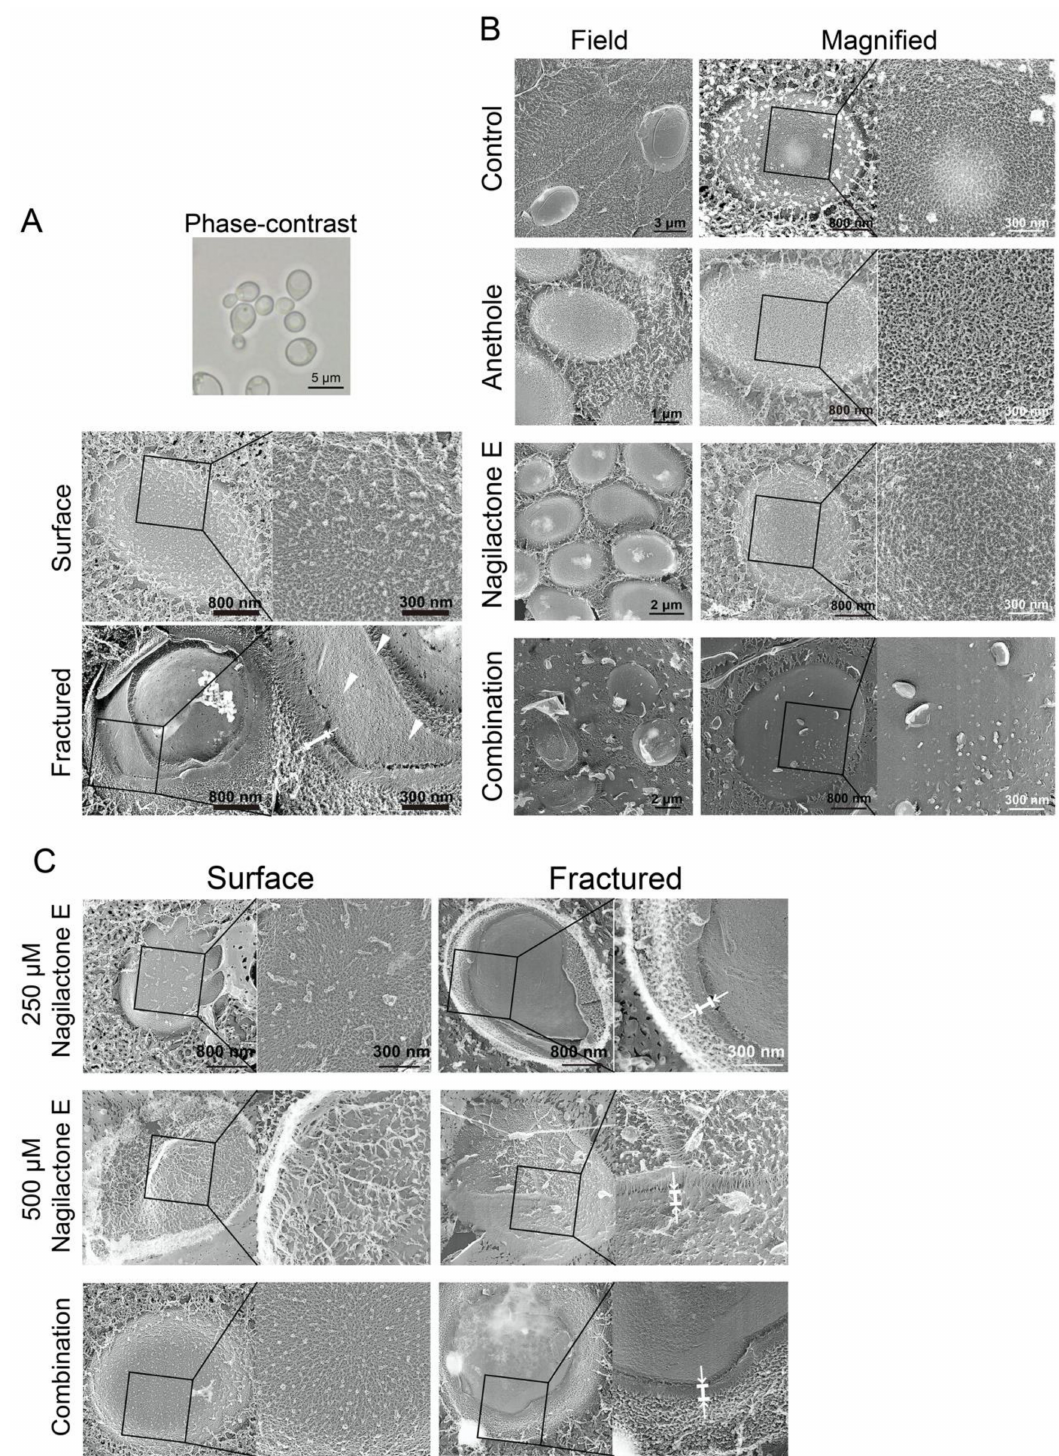
Figure 6. Quick-freeze deep-etch replica images of S. cerevisiae BY4741 cells. ( A ) The surface and fractured images of yeast cells (magnified). Exponentially growing cells without drug treatment were observed. ( B ) The surface of yeast cells in field and magnified images. Exponentially growing cells were grown at 30 ◦ C for 72 h in 2.5% ME treated with 312.5 µ M anethole, 250 µ M nagilactone E, or their combination. Control denotes treatment without drugs. ( C ) The surface and fractured images of yeast cells (magnified). Exponentially growing cells were grown at 30 ◦ C for 48 h in 2.5% ME treated with 250 and 500 µ M nagilactone E and 250 µ M nagilactone E combined with 312.5 µ M anethole